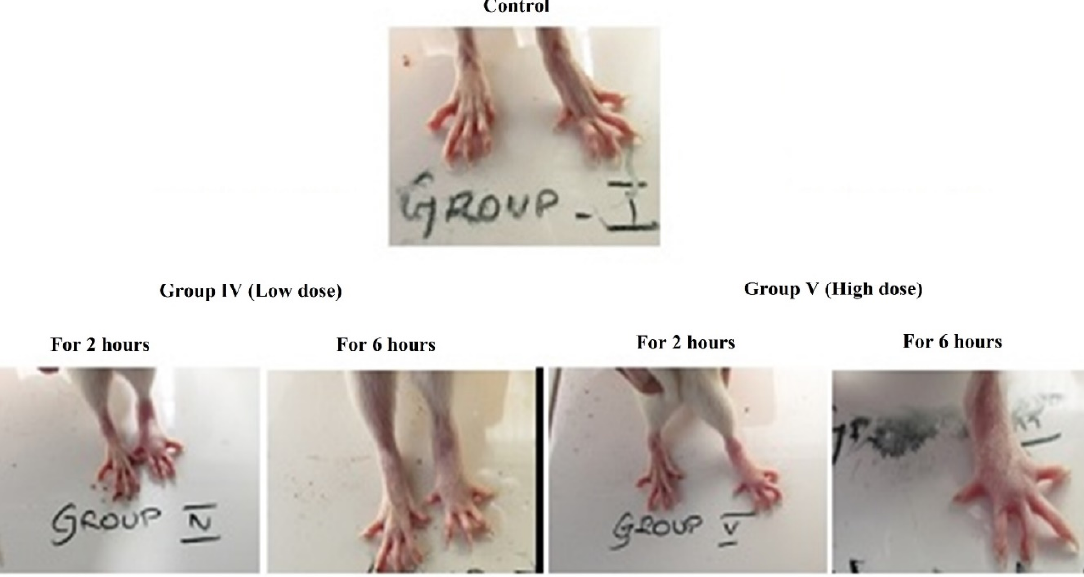
Figure 5. Anti-inflammatory response of dimer of epicatechin (DoE) on Wistar